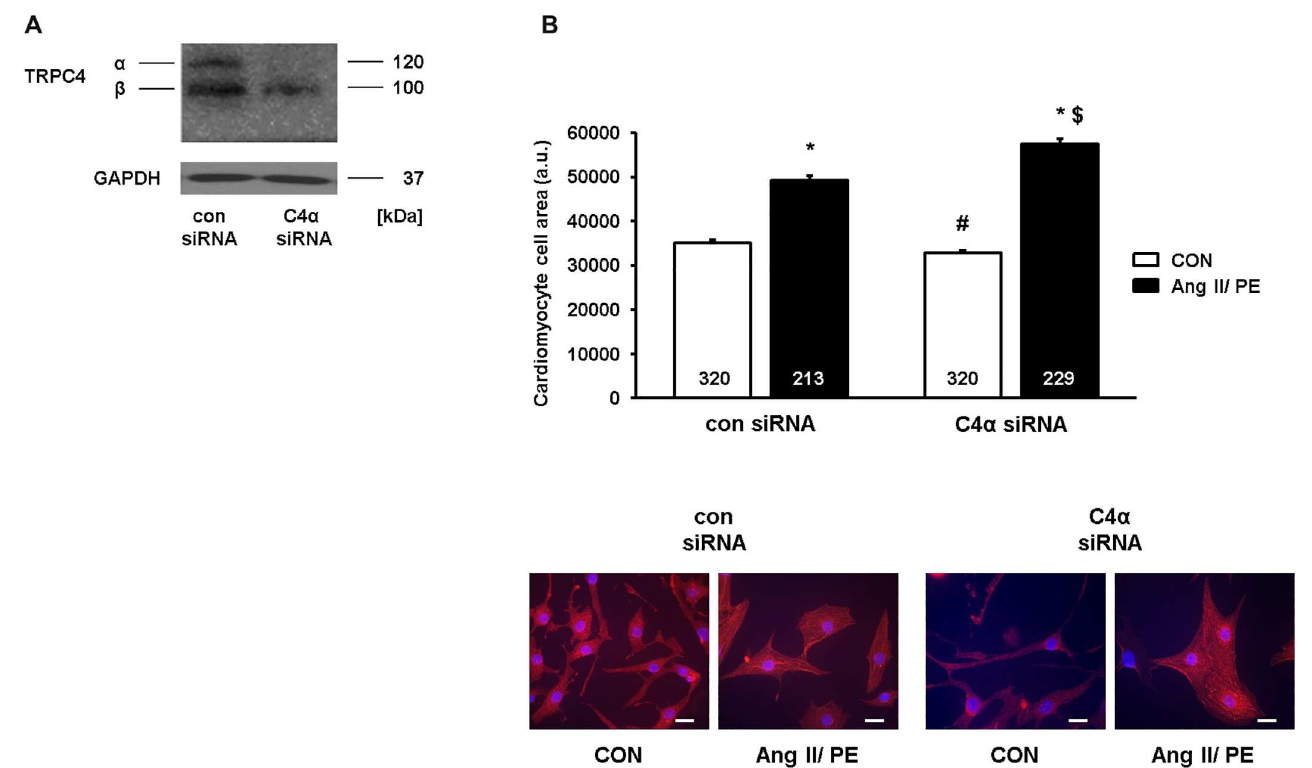
Fig 7. Down-regulation of endogenous TRPC4 α decreasesbaseline cardiomyocyte size and promotes cardiomyocyte hypertrophy after chronic agonist stimulation. A, TRPC4 α was down-regulated in neonatal rat cardiomyocytes (NRCs) by a siRNA-dependent approach.Down- regulationof TRPC4 α was verifiedby Western blotting. B, Hypertrophic growth of NRCs transfected with control siRNA (con siRNA) or TRPC4 α (C4 α ) siRNA was measuredas an increaseof the cell surface after angiotensin II/phenylephrine (Ang II/PE) or vehicle (CON) treatment for 24 h. Red: α - actinin; Blue: DAPI. * P < 0.05vs con siRNA and C4 α siRNA CON; # P < 0.05vs con siRNA CON; $ P < 0.05vs con siRNA Ang II/PE. Cells from three different experiments were analyzed.Scale bar: 20 μ m. N-numberof cells is indicatedin the bars.